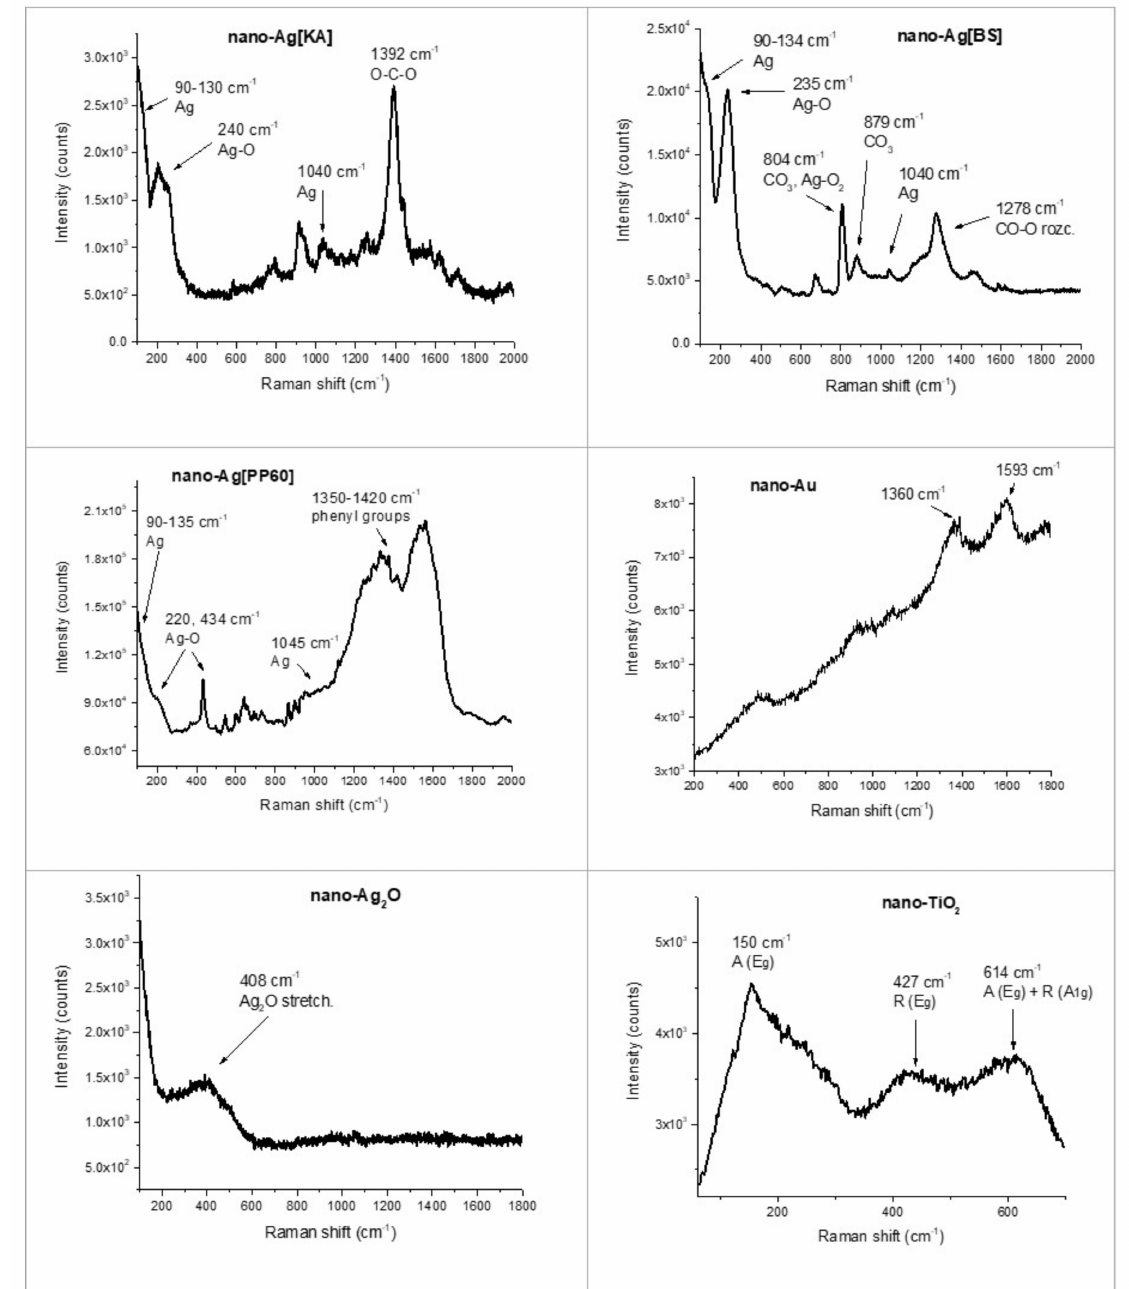
Figure 7. Raman spectra of nano-Ag—Ag[KA], Ag[BS], and Ag[PP60]—nano-Au, nano-Ag 2 O, and nano-TiO 2